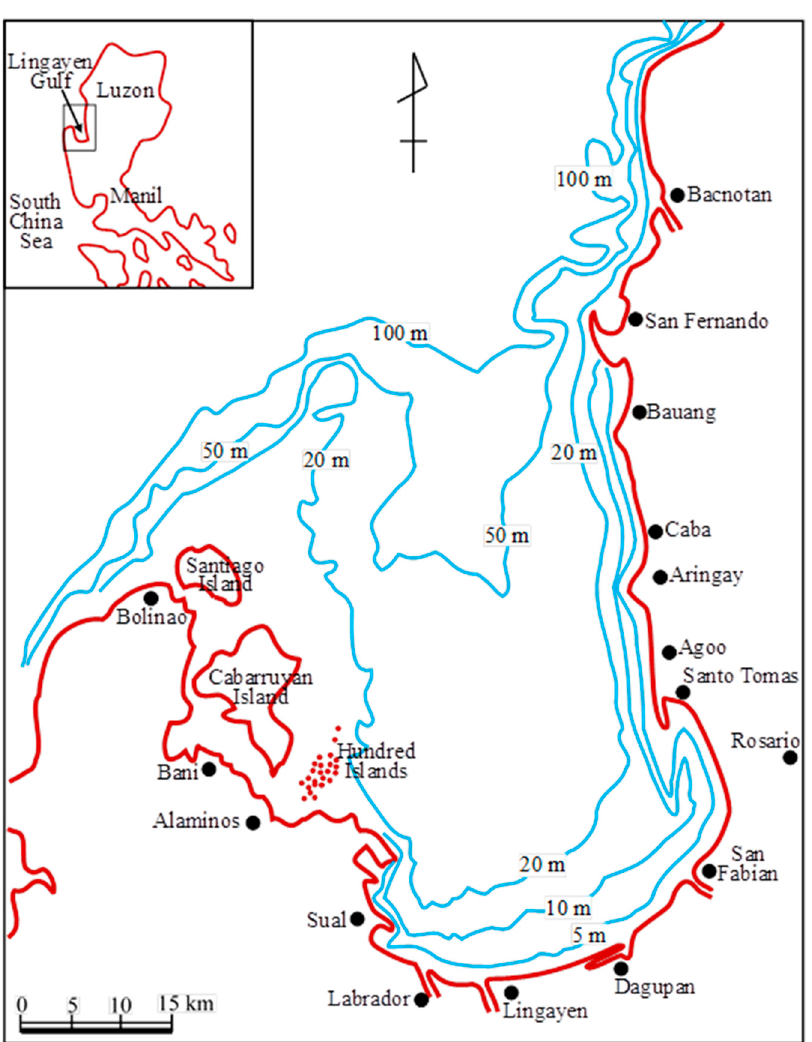
Figure 2. Bathymetric chart of Lingayen Gulf in the Philippines (modified from [10]).